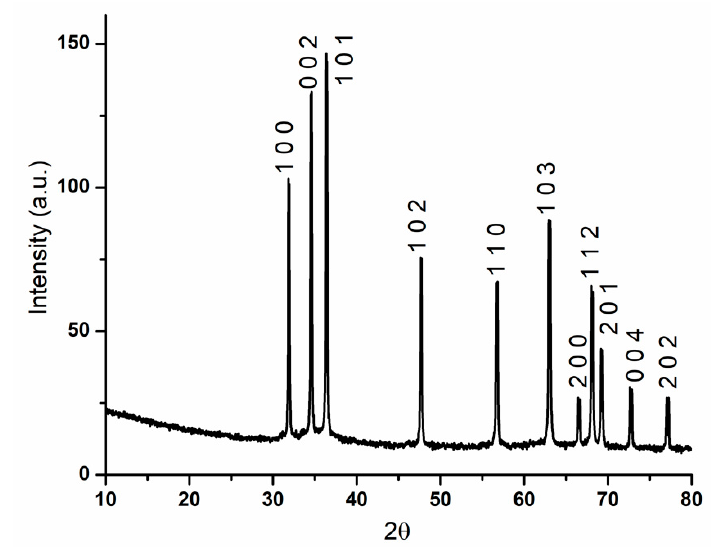
Figure 4. XRD pattern for ZnO nanoparticles.